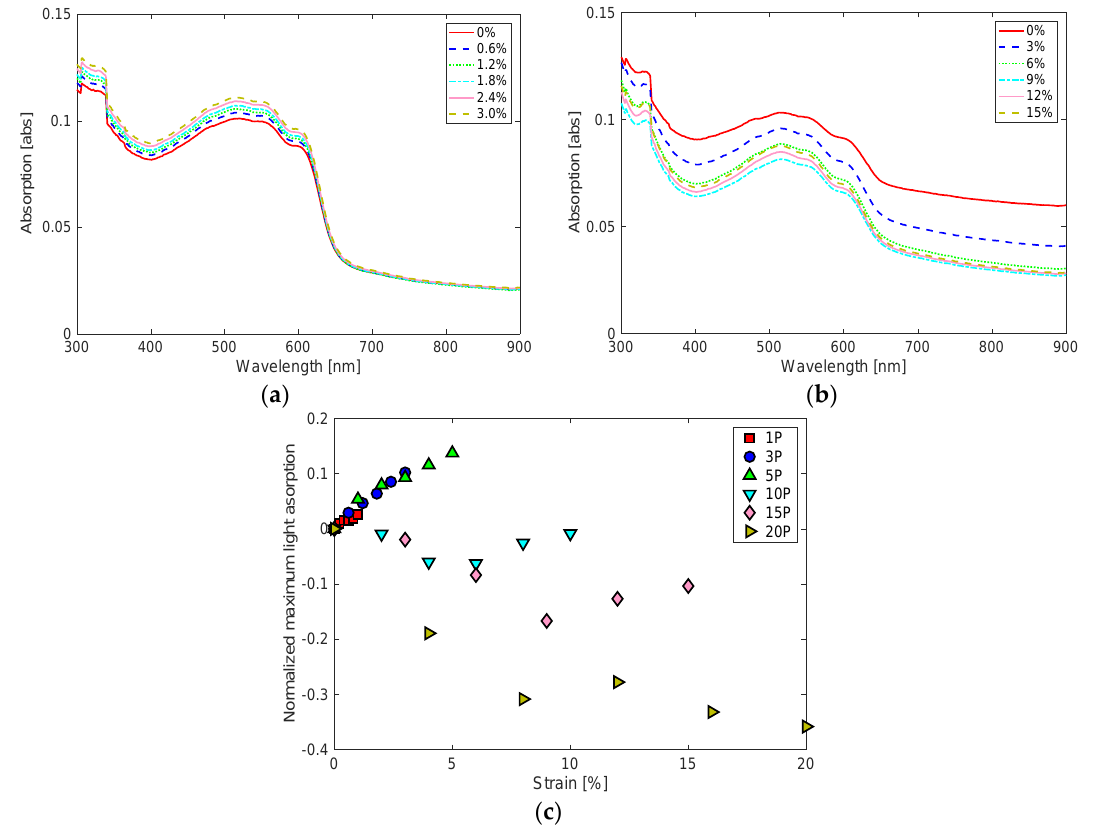
Figure 11. Light absorption spectrums of ( a ) 3P and ( b ) 15P P3HT:PCBM thin film specimens are shown at various strains from 0% to pre-strain levels, which are 3% and 15%, respectively. ( c ) Corrugated P3HT:PCBM thin film specimens that are fabricated at low pre-strain show increasing trend, while other specimens fabricated at higher pre-strain (i.e., above 10%) show decreasing trend, as the applied strain increases.